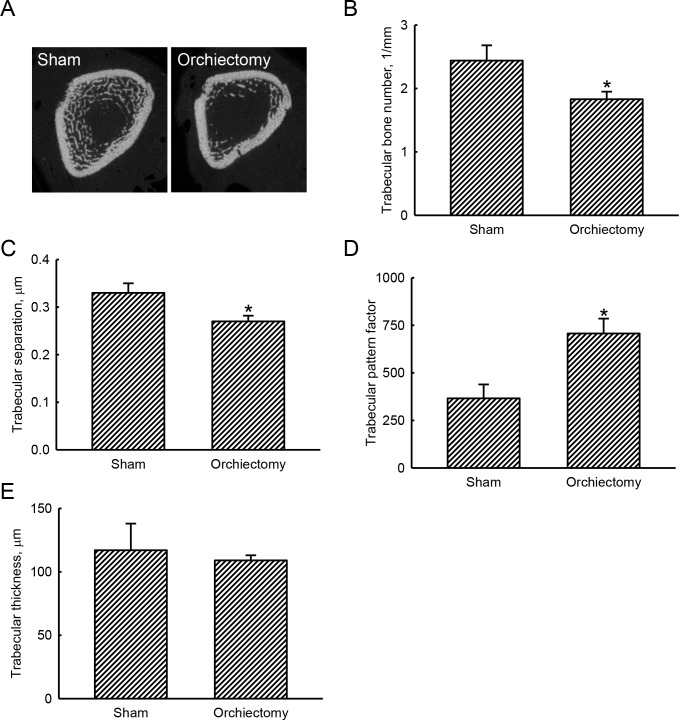
Effects of orchiectomy on tomographic changes of trabecular bone.Male Wistar rats were subjected to sham operation or orchiectomy. Four weeks after surgery, animals from the sham and orchiectomy groups were sacrificed, and their femurs were collected for analysis by micro-computed tomography (μ-CT). The distal femur was scanned with μ-CT, and representative cross-sectional images are presented (A). Tomographic parameters, including the trabecular bone number (B), trabecular separation (C), trabecular pattern factor (D), and trabecular thickness (E), were examined and statistically analyzed. Each value represents the mean ± SD of three independent determinations. * Indicates that the value significantly (p < 0.05) differed from the sham group.